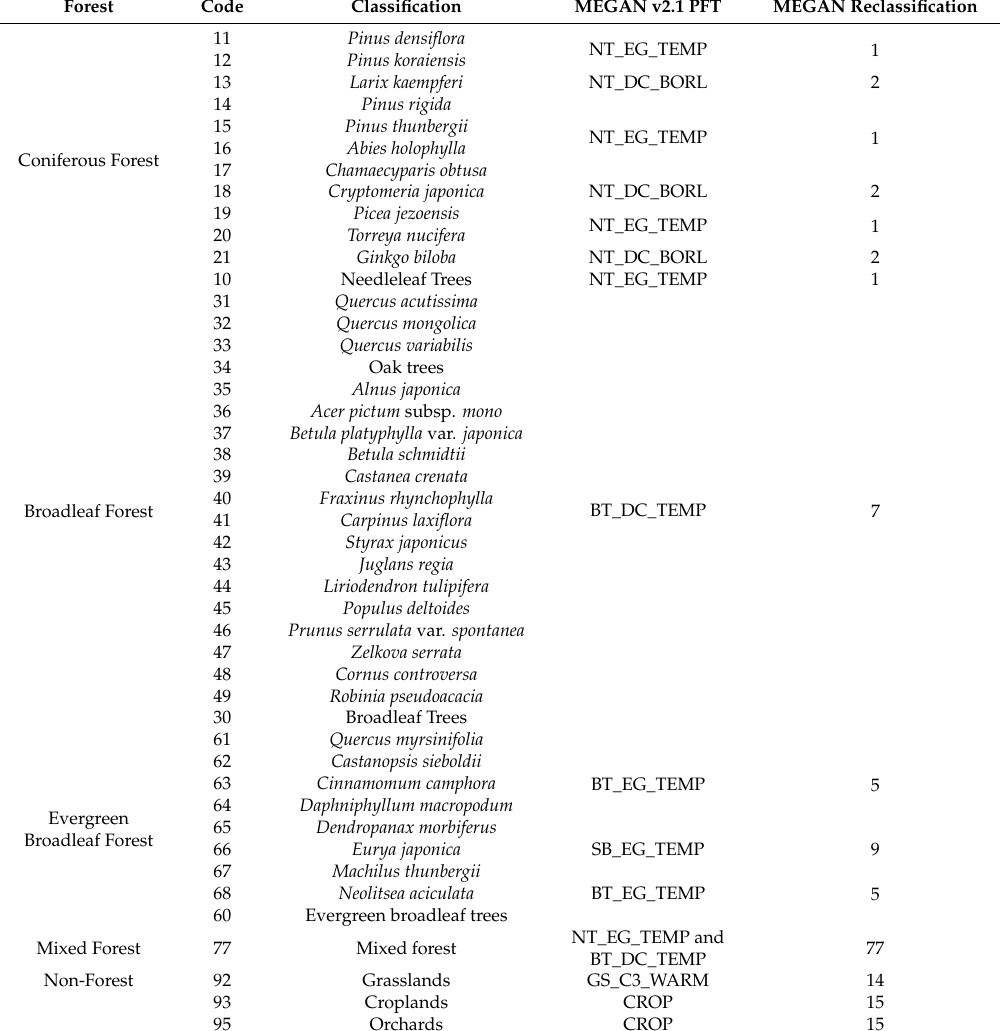
Table 4. Mapping vegetation classes of the Korea Forest map into MEGAN v2.1 PFT [8].